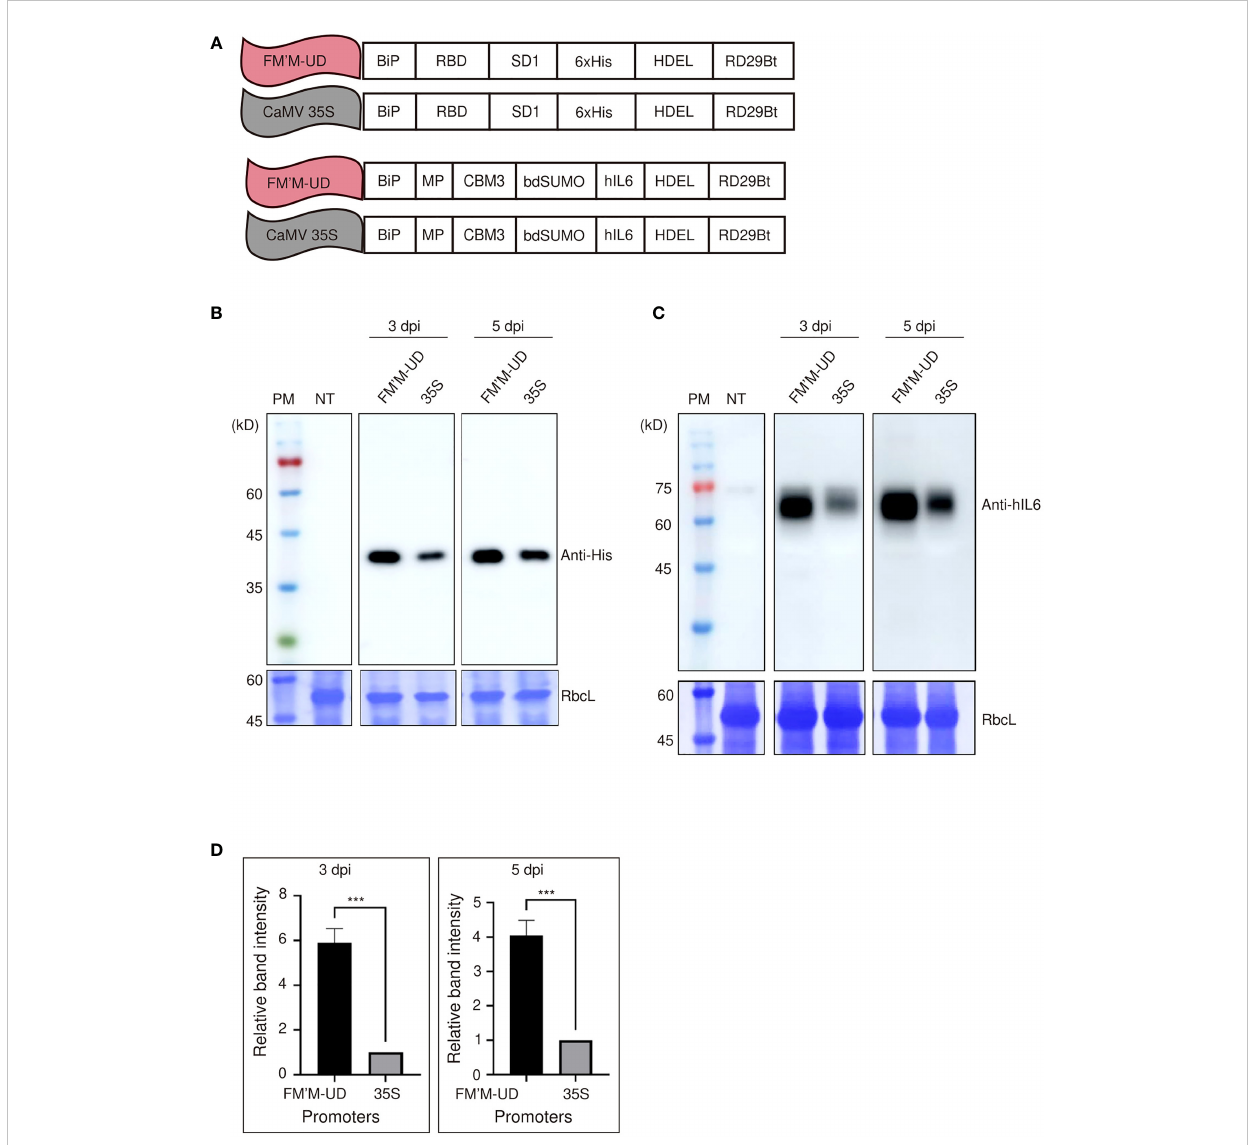
FIGURE 3 The FM ′ M-UD promoter induces strong expression of other reporters in N. benthamiana . (A) Schematic presentation of the reporter constructs containing RBD : SD1 and BMCS:hIL6 . (B, C) Expression analysis of the reporters at the protein level. Total soluble proteins were prepared from leaf tissues harvested at 3 and 5 dpi, and used in western blot analyses using anti-His (B) and anti-hIL6 (C) antibodies. As a loading control, identical membranes were stained with CBB to detect the level of RbcL. (D) Quanti fi cation of protein expression levels. To quantify the expression levels driven by the hybrid promoter and CaMV35S promoter, the band intensities of western blot images in (C) were measured using the LAS-3000 imaging system. The expression levels from the FM ′ M-UD promoter are relative to that produced by the CaMV 35S promoter. The data shown are means ± SE (n = 3). Asterisks shown in (D) indicate statistically signi fi cant differences determined by two-tailed Student ’ s t -tests; ***: P <